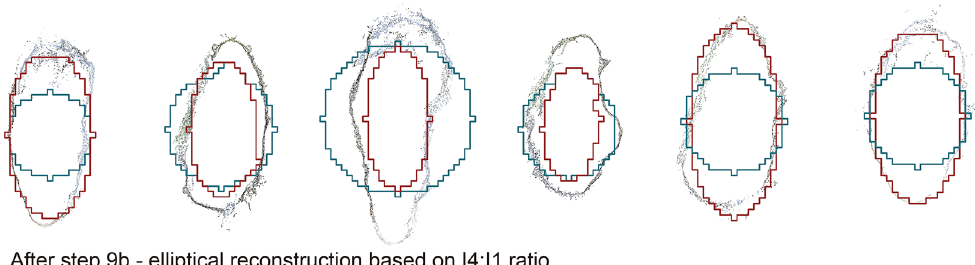
Figure 6. Examples of elliptical root sample PCs, reconstructed in step 9a as circles (blue) and 9b ellipses